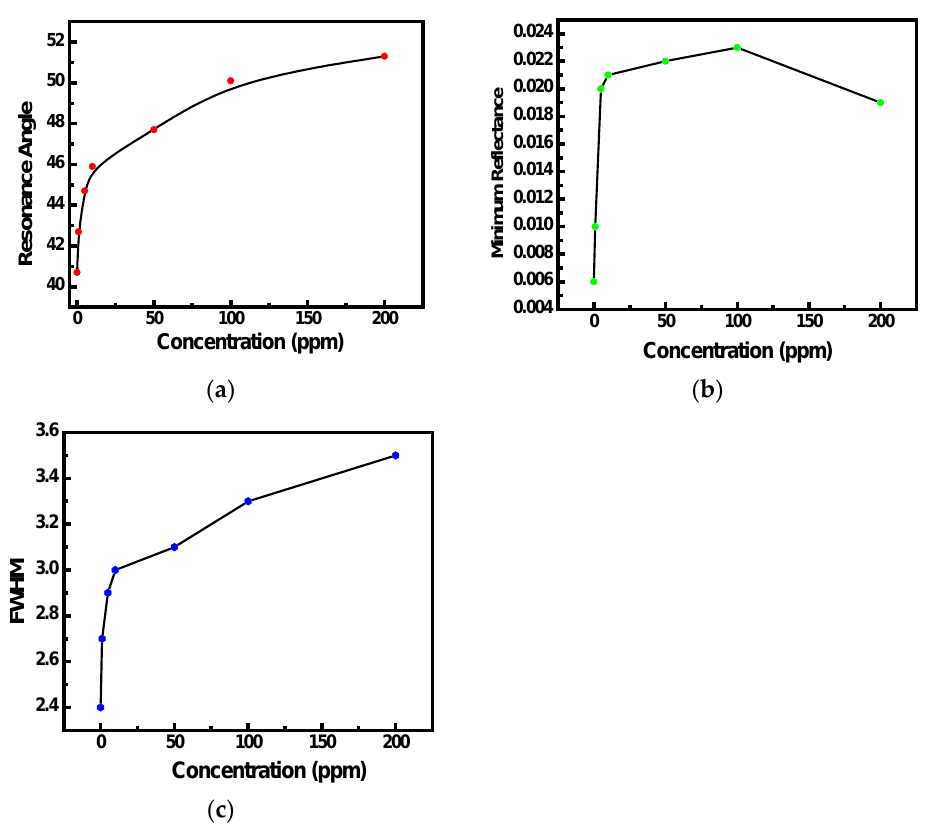
Figure 5. Variation of ( a ) SPR dip angle ( θ SPR ), ( b ) R min , and ( c ) FWHM for the SPR sensing system with different concentration of NH 3 gas.